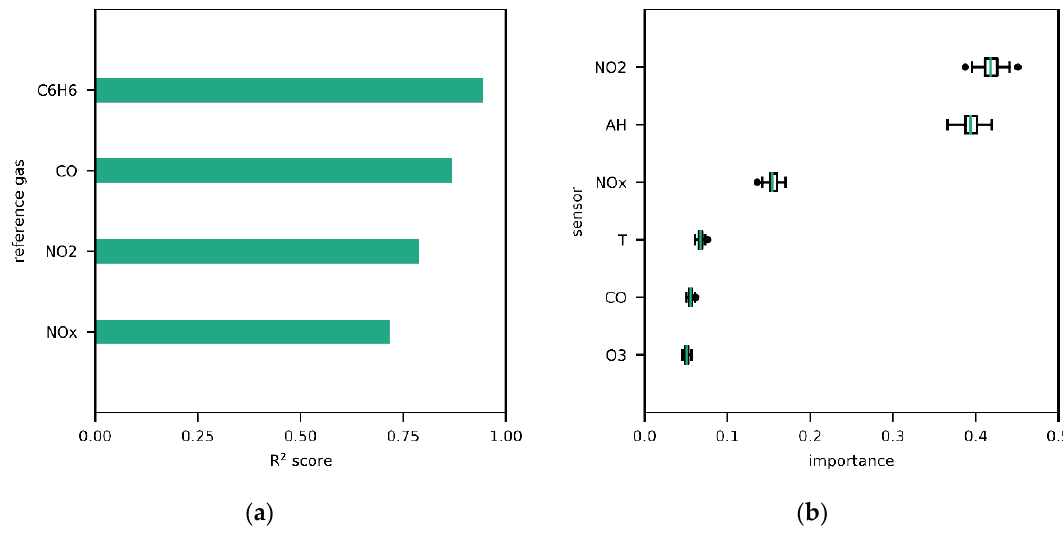
Figure 2. ( a ) Model performance of the NN with respect to individual references; ( b ) permutation feature importance of all features in the NN model.